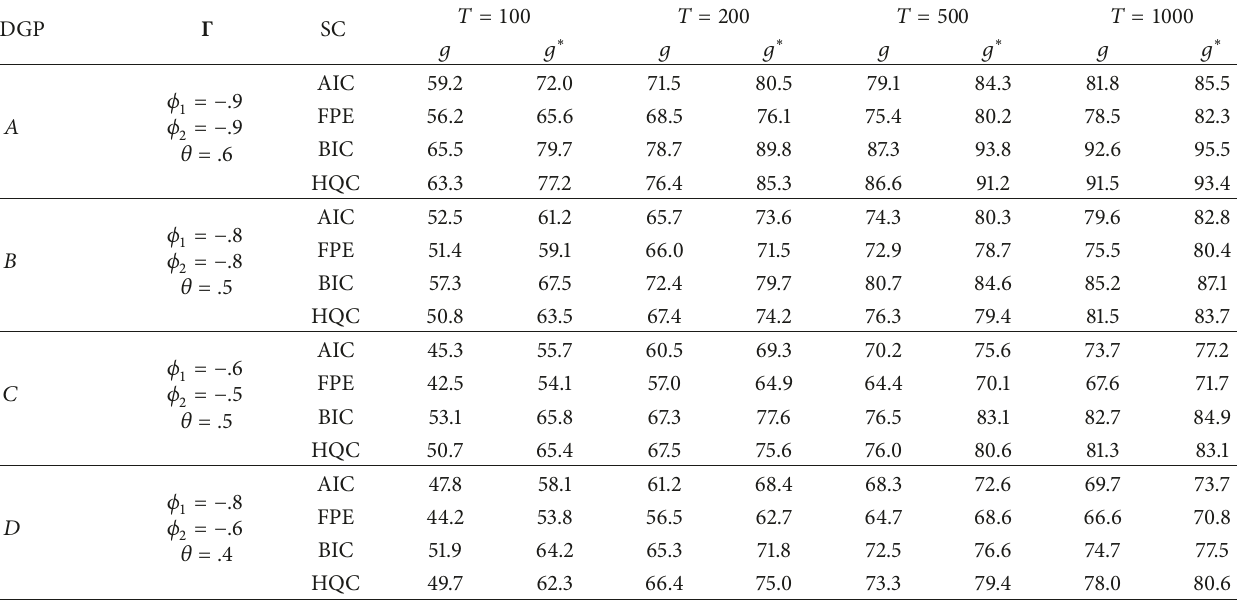
Table 4: Frequency of selection of the true model in the nonbootstrap ( 𝑔 ) and bootstrap ( 𝑔 ∗ ) world, for different sample sizes.